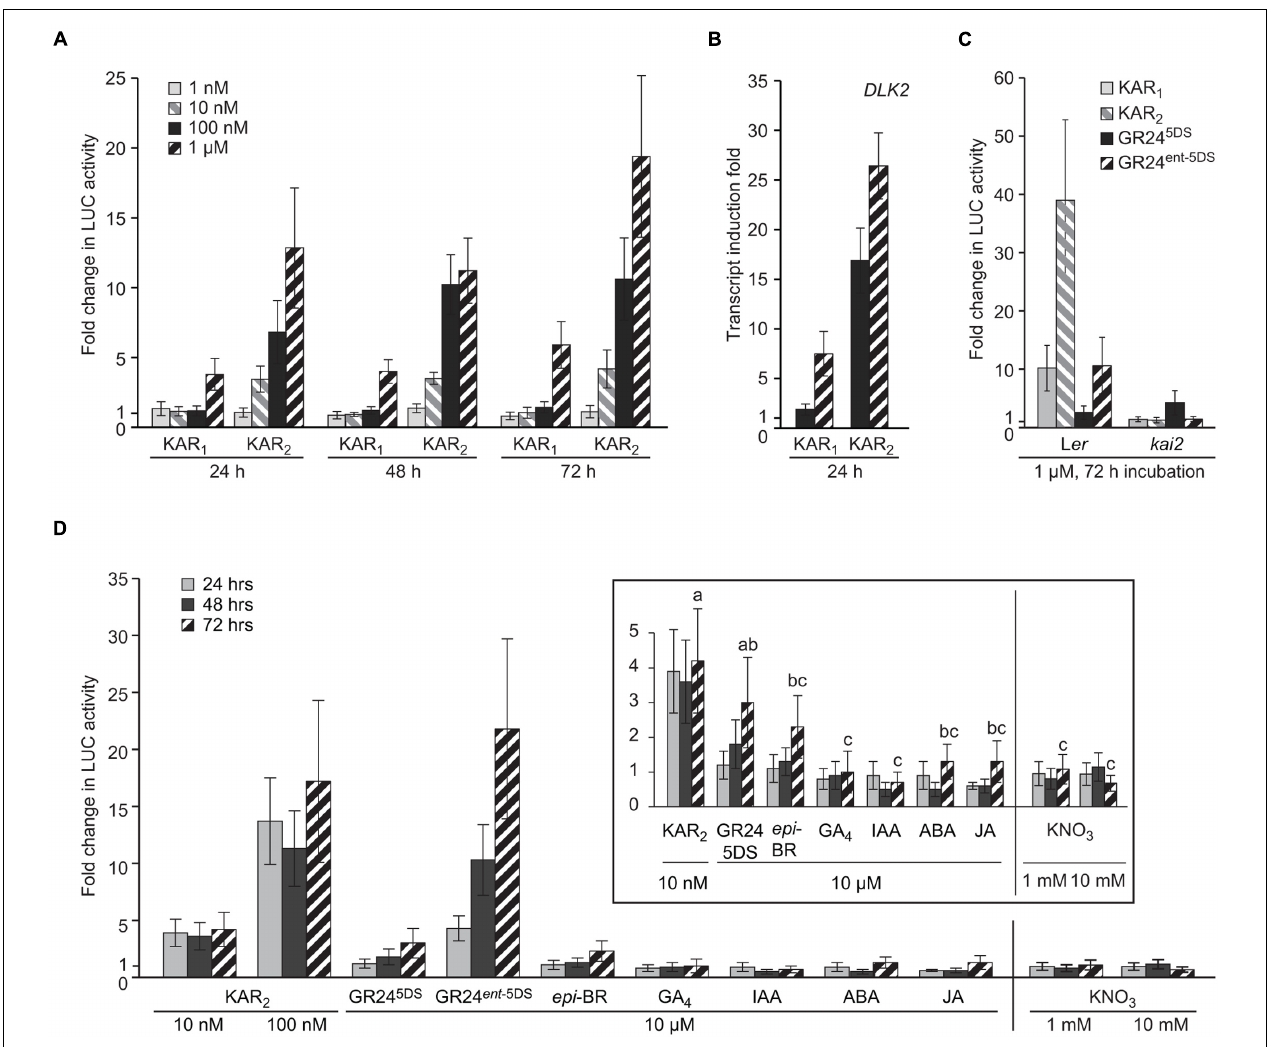
FIGURE 2 | DLK2:LUC Specifically Responds to KAI2 Substrates. (A) Sensitivity of the DLK2:LUC assay to KAR 1 and KAR 2 at a range of concentrations over 24, 48, and 72 h. Data are expressed as fold change in LUC activity relative to a mock sample of seeds treated with water for the same duration. (B) Sensitivity of DLK2 transcripts to KAR 1 and KAR 2 at a range of concentrations over 24 h in L er seeds. Data are expressed as fold change relative to mock sample of seeds treated with water for the same duration. (C) Specificity of the DLK2:LUC assay toward karrikins and strigolactones in L er and kai2 backgrounds treated for 72 h. (D) Specificity of the DLK2:LUC assay toward strigolactone analogs, selected plant hormones, and the germination stimulant KNO 3 . Vertical line indicates separate experiments. Inset shows the same data scaled for smaller fold changes. Shared lower case letters indicate no significant difference between 72 h treatments, and “c” indicates no significant difference from mock treatment (ANOVA; P < 0.05). In all charts, error bars depict SE, n = 8